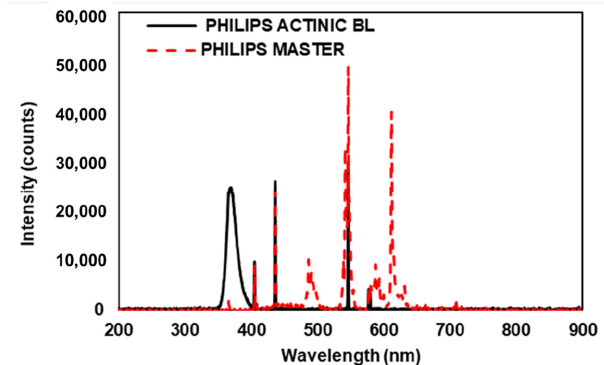
Figure 13. Light spectra for visible (Philips master) and UV-Visible (Philips actinic BL)